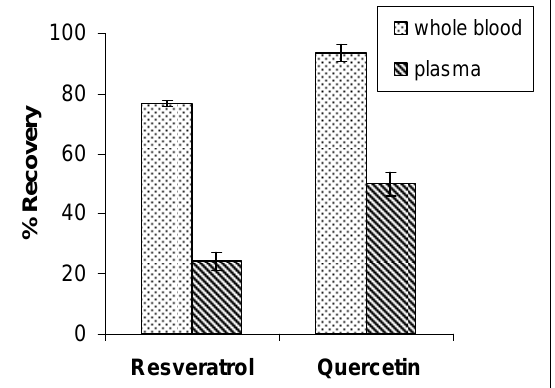
Figure 3. Mean recoveries of resveratrol and quercetin from whole blood and plasma, coming from samples spiked with 5 μ M quercetin or resveratrol (N =